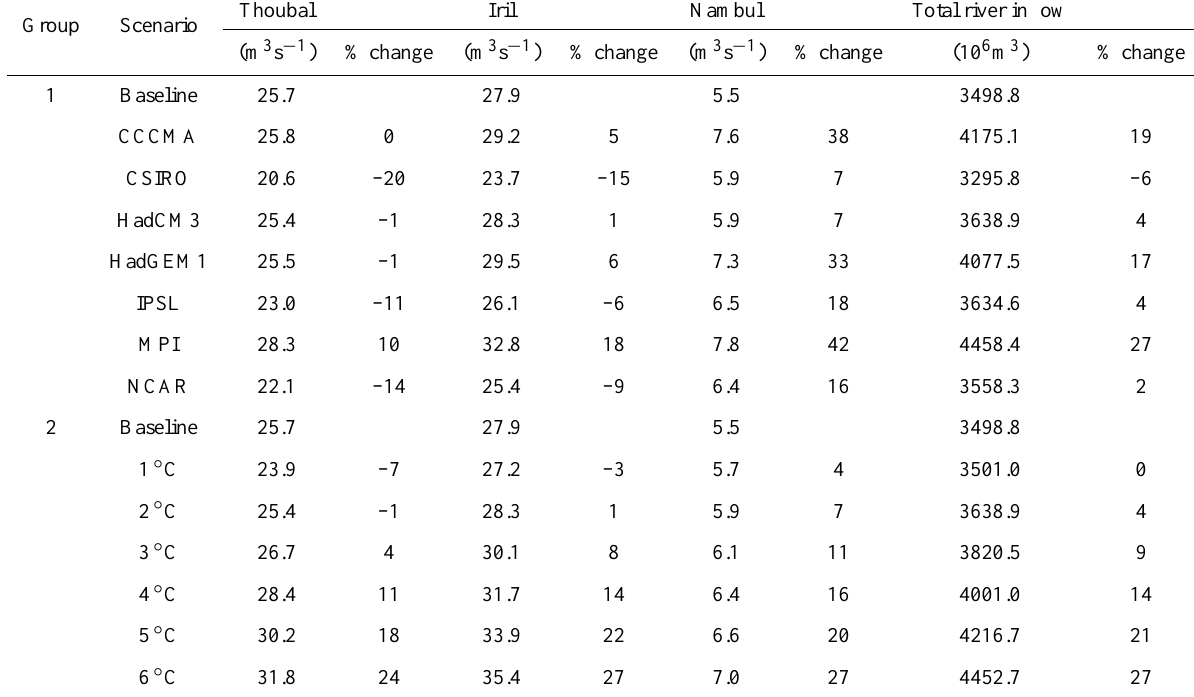
Table 6. Changes in the mean daily discharge of the three modelled sub-catchments and total annual river inflow to Loktak Lake due to the climate change scenarios.